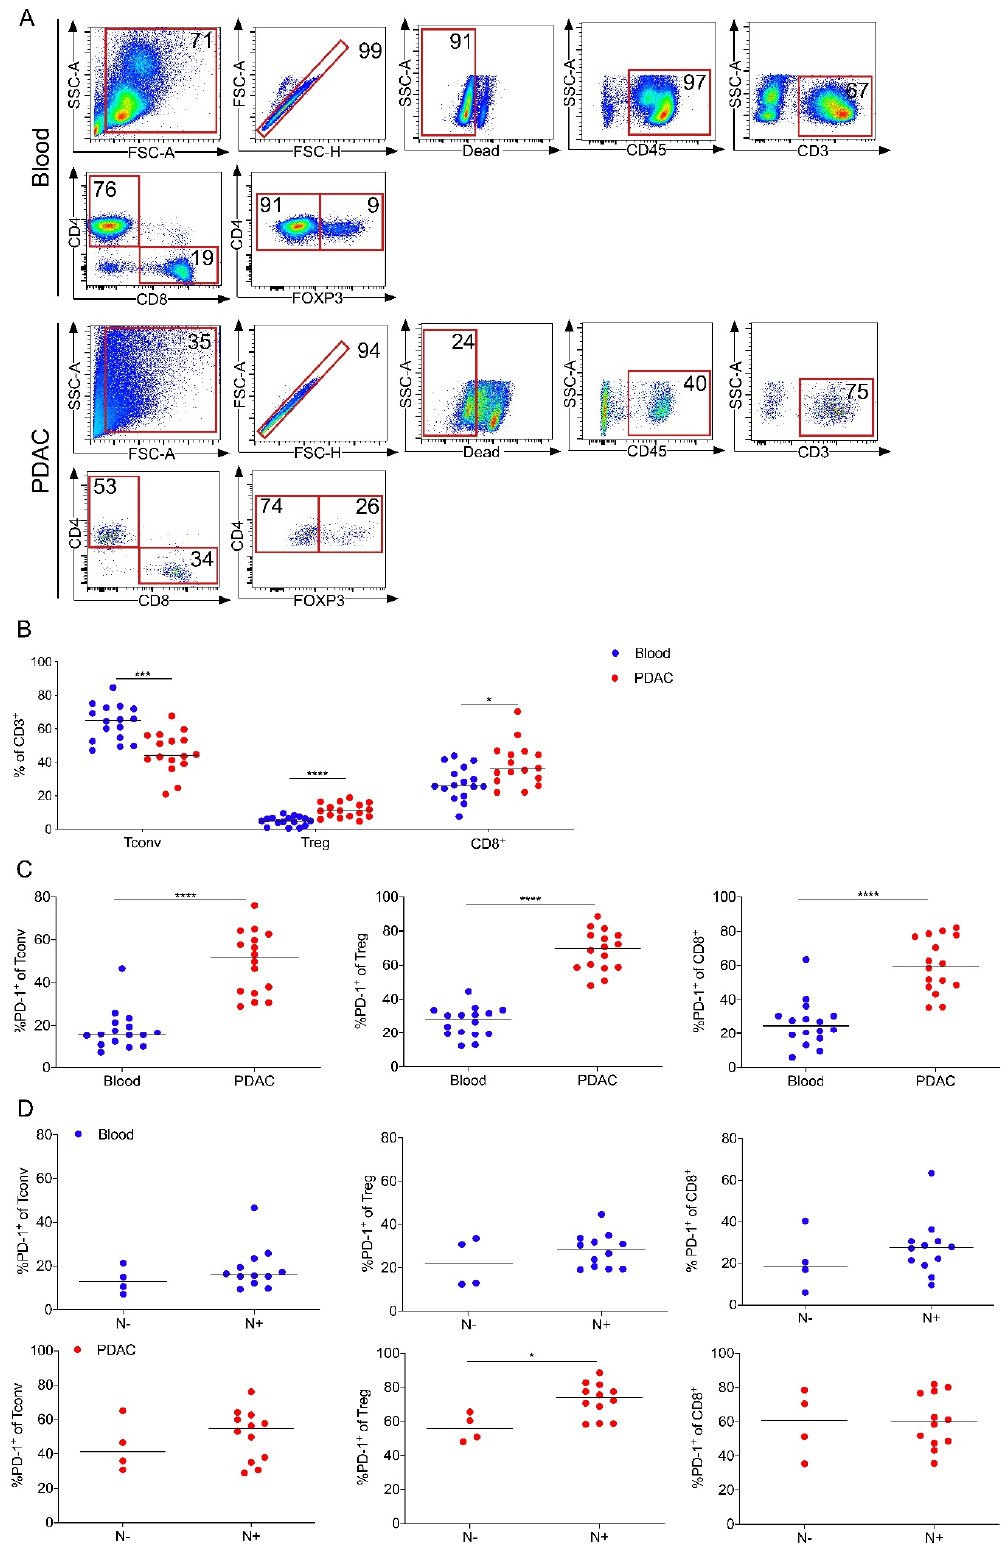
Figure 6. PD-1 expression by intratumoral Treg cells correlates with node-positive PDAC. ( A ) Representative flow cytometric gating strategy for the identification of T cells in blood (top) and PDAC (bottom). Number indicates percentage of population per gate. SSC, side scatter; FSC, forward